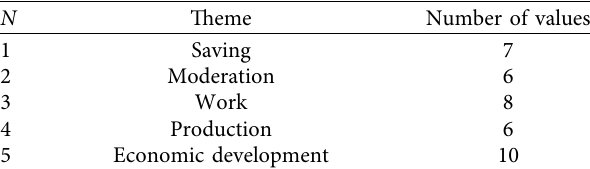
Table 1: Economic values and the number of values in each